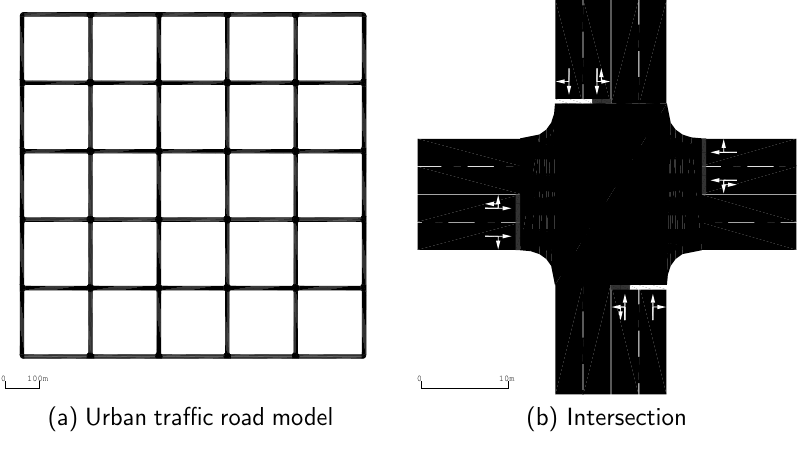
Figure 2. Simulation